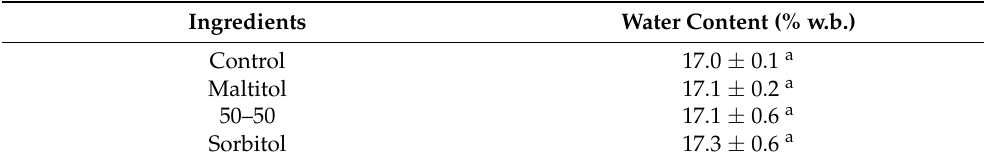
Table 4. Water contents of doughs (%, w.b.).